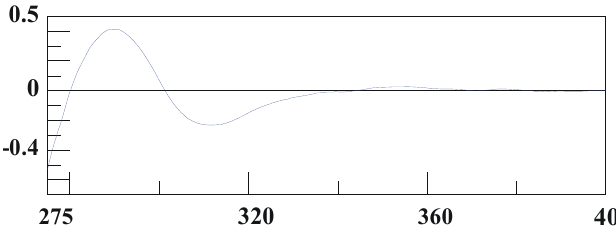
Figure 2. X ‐ ray structure (+) ‐ (R) ‐ DIDAB and it CD spectrum in CH 3 CN.